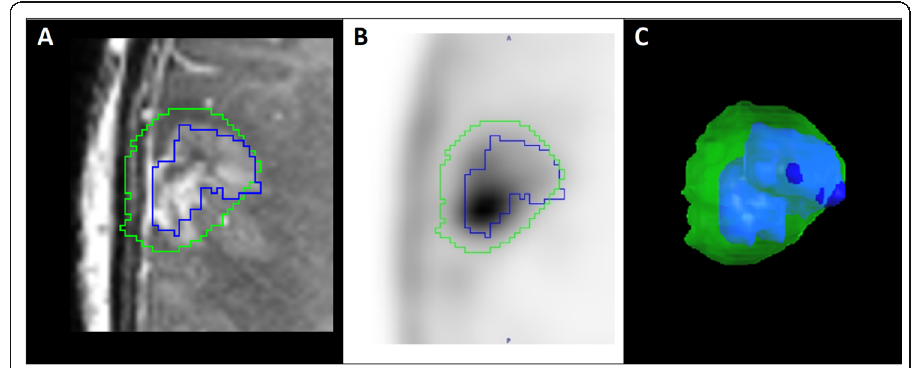
Fig. 4 PET and MRI VOIs of cerebral tumour from scan 4. An example of the relationship between PET (green) and MRI (blue) tumour volumes that occurred in all four scans. a Zoomed in axial view of T1 MRI CE image and b PET image from scan 4. c 3D representation showing PET VOI encompassing MRI CE VOI from scan